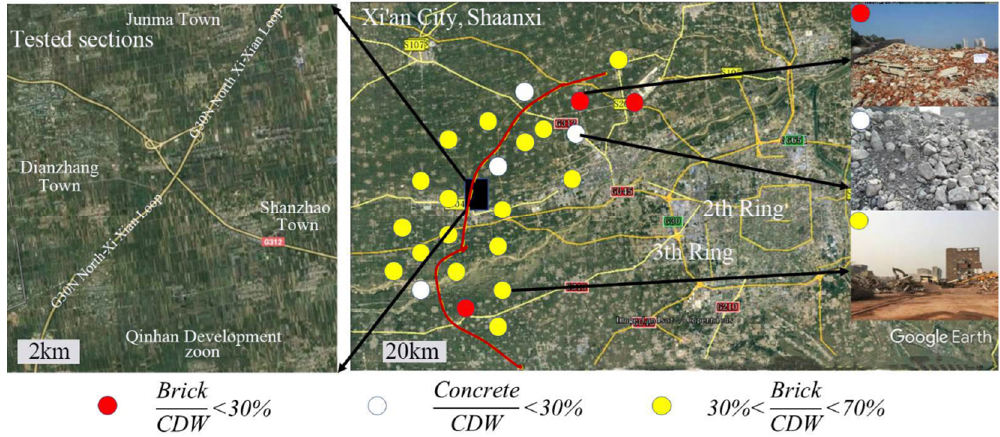
Figure 1. Construction and demolition waste (CDW) site distribution along the highway to be built.